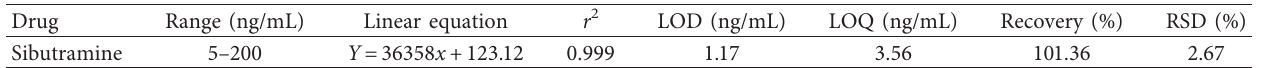
Table 2: Linearity range, detection limits, and summary of method validation data for HPLC analyses.